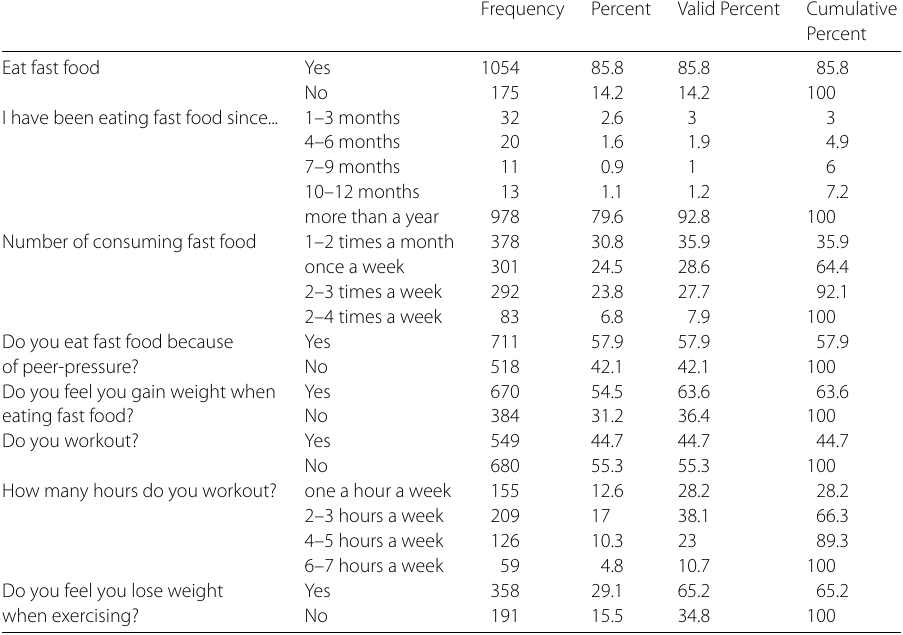
Frequency Percent Valid Percent Cumulative Percent